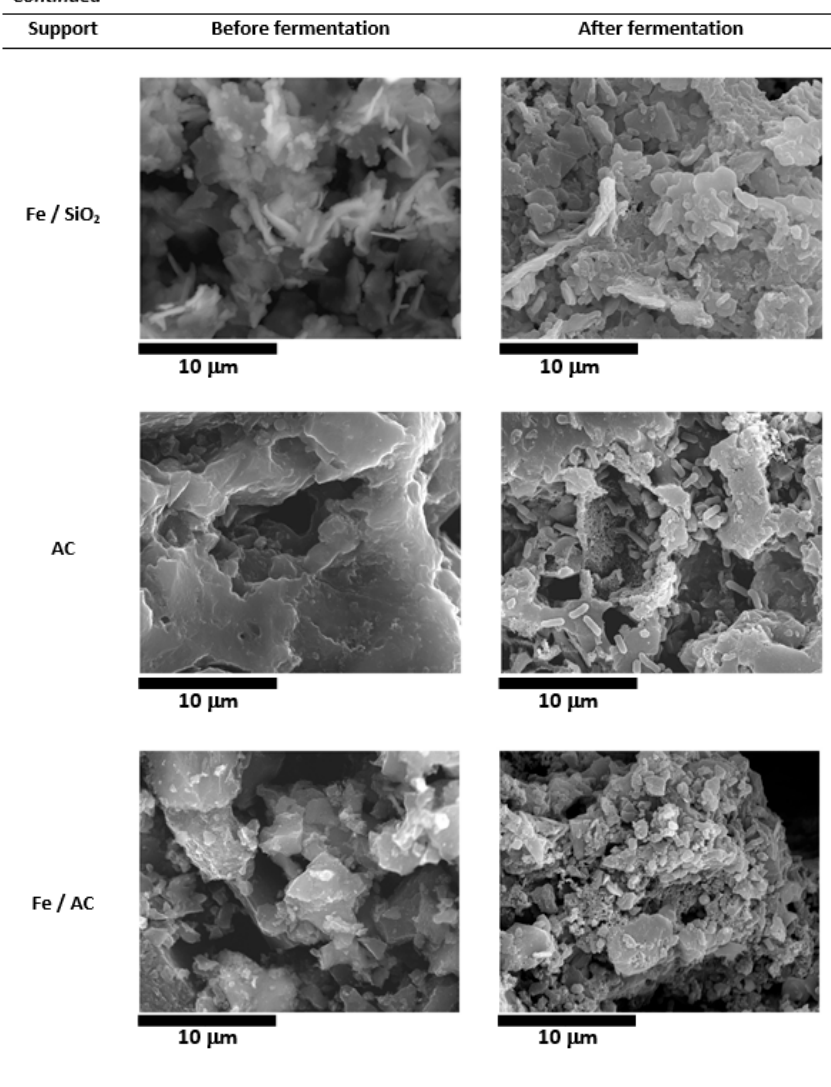
Figure 3. SEM images of bare support and attached cells before and after dark fermentation. Effect of Supports on Bacterial Surface Attachment